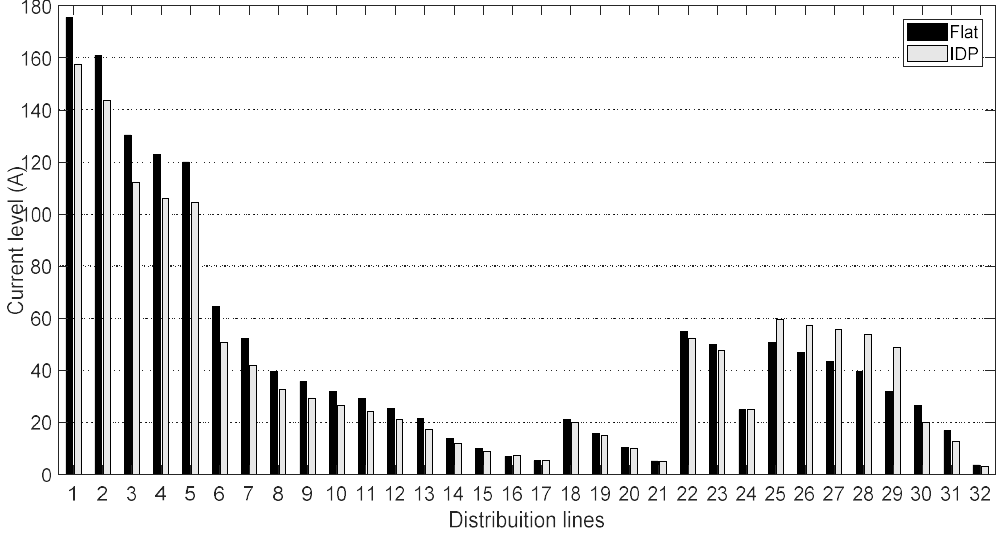
Figure 11. Current level on distribution lines with PV generation.